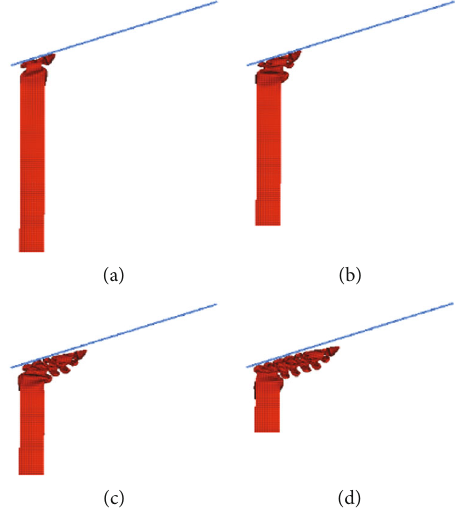
Figure 34: The deformation history of TRB tube. Table 8: Crashworthiness parameters of four con fi gurations of the thin-walled